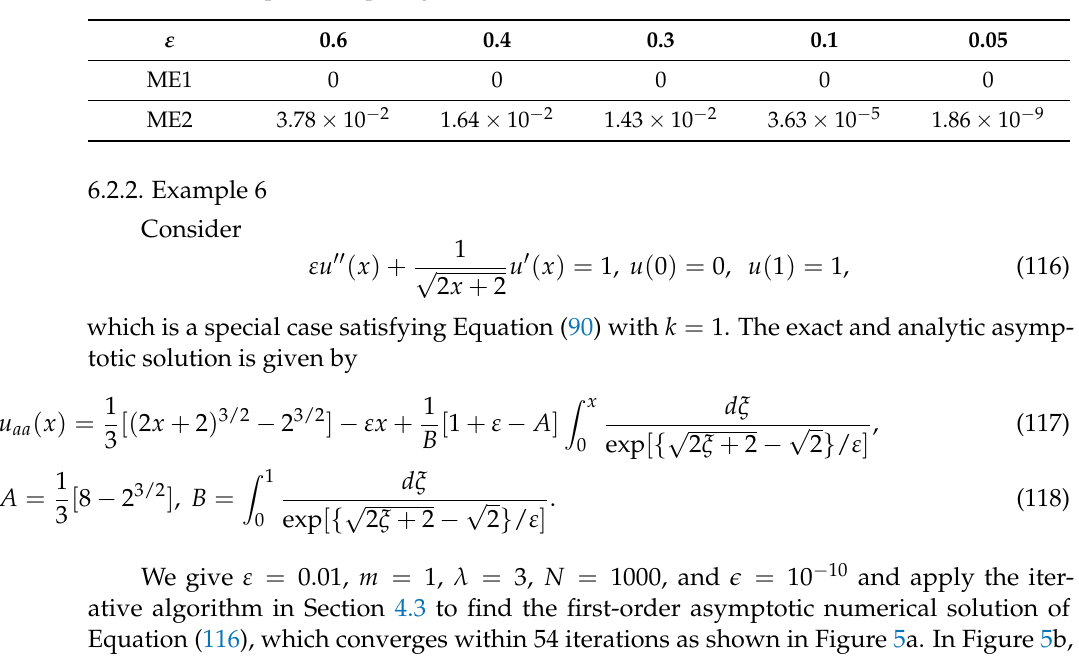
Table 3. For example 5, comparing ME1 and ME2 for different ε